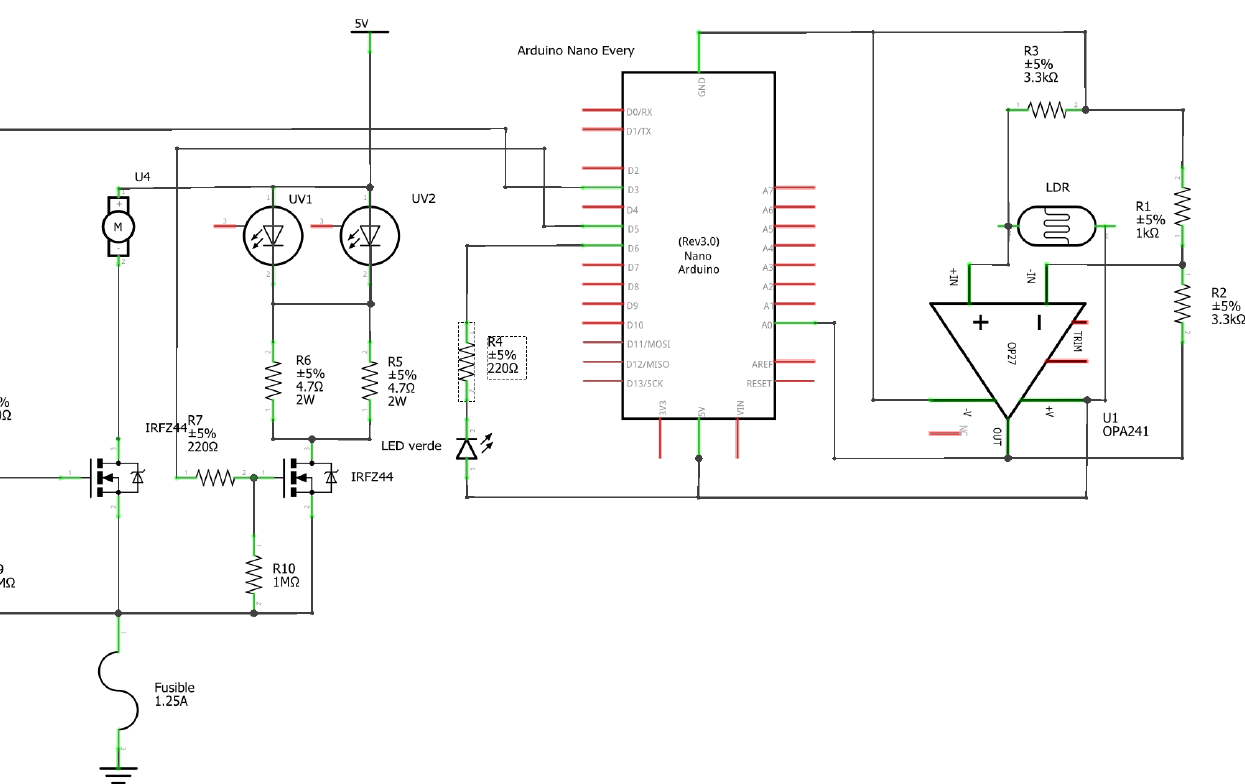
Figure 4. Electronic